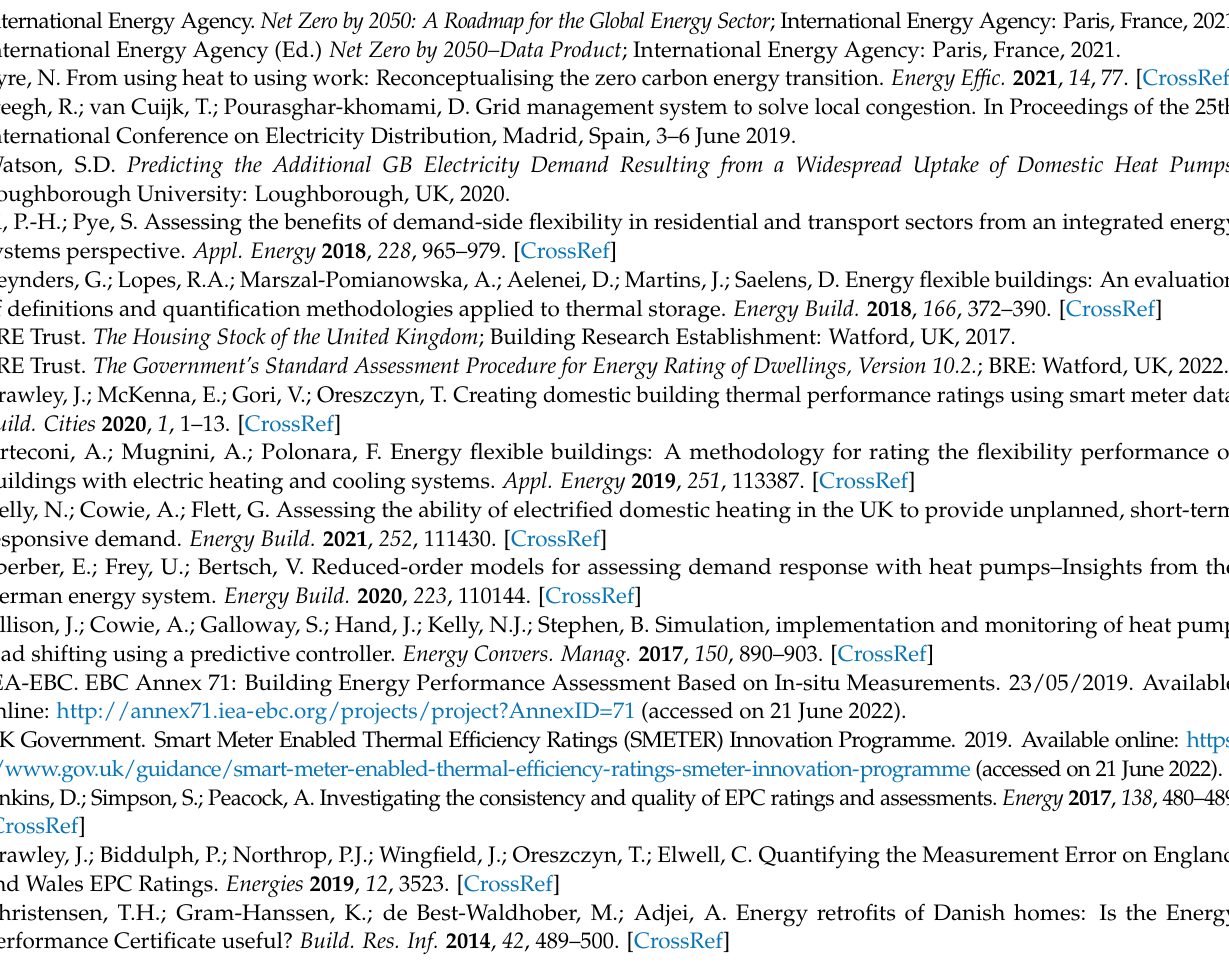
Figure A2. Comparison of the algorithm’s output to the ground truth for IDEAL home no.